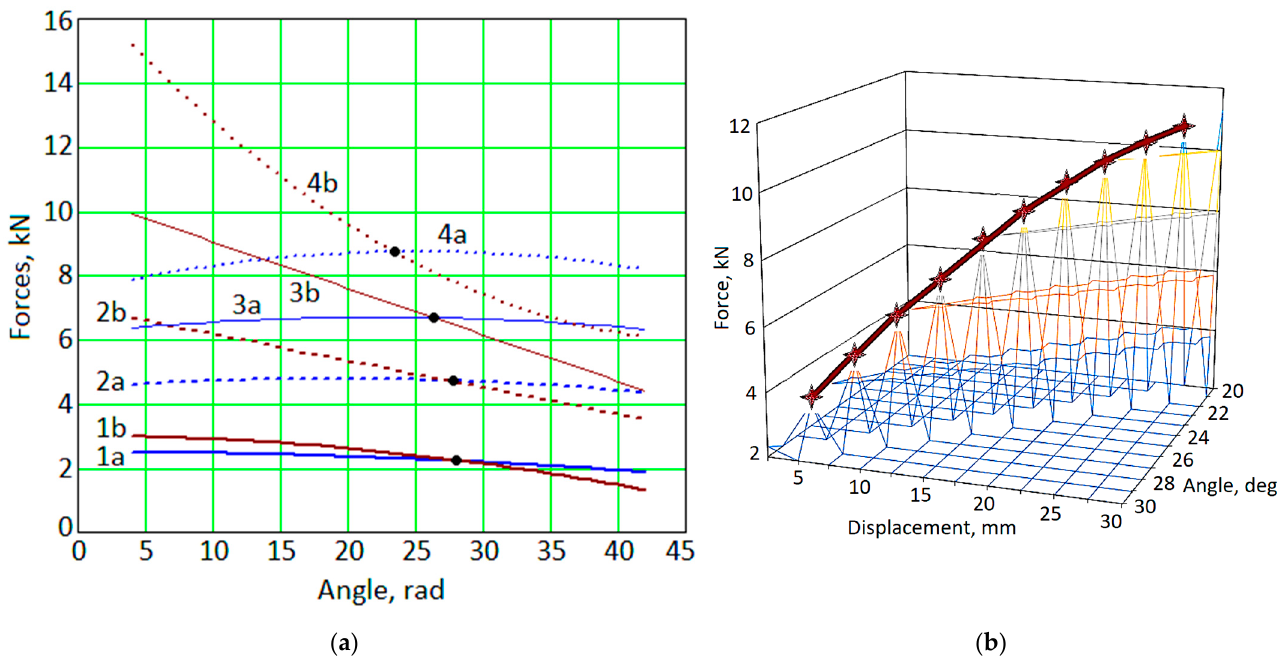
Figure 15. Dependencies of Q k ( S k , β k ) [kN] ( a ) and Q ( S , β ) [kN] ( b ) on the displacements S , S k [mm] and the angle β k and β [deg]: a— Q 1 ; b— Q 2 ; 1— S = 5 mm; 2— S = 10 mm; 3— S = 15 mm; 4— S = 20 mm.